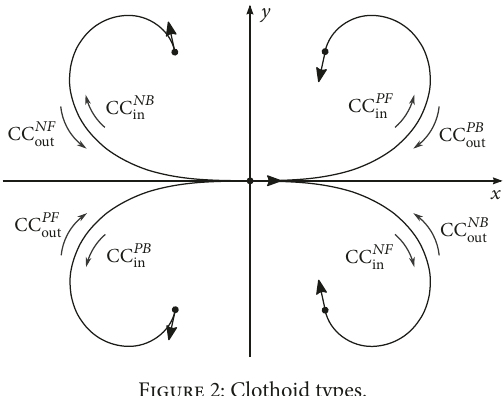
Figure 2: Clothoid